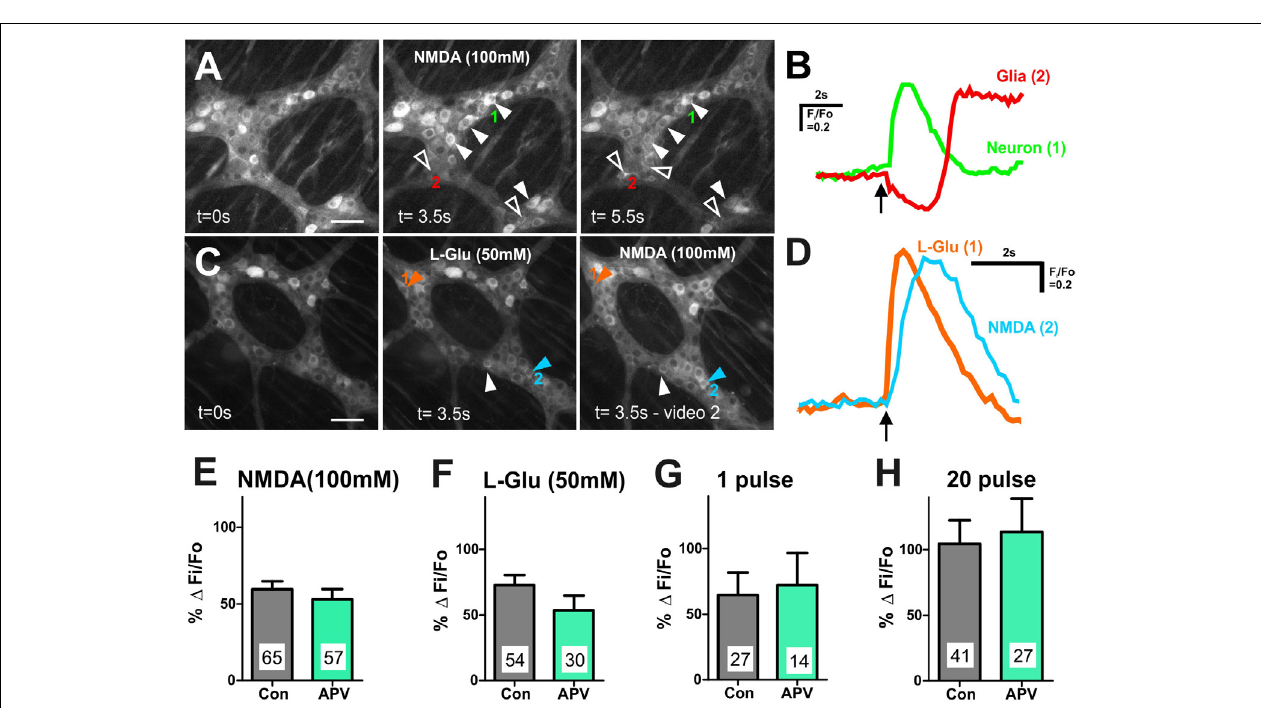
FIGURE 4 | Many myenteric neurons exhibited [Ca 2 + ] i transients in response to L -Glu and NMDA. (A) Representative fluorescence micrographs of NMDA (100 mM) evoked [Ca 2 + ] i transients in myenteric neurons (filled arrowheads) and glia (open arrowheads) [GCaMP3 signal at rest ( t = 0 s) and during NMDA spritz in neurons ( t = 3.5 s) and in glia ( t = 5.5 s)]. (B) Example traces from a neuron (1) and a glial cell (2; marked in A ) that responded to L -Glu. Glial cell shows delayed response to NMDA compared to the GCaMP3+ neuron. Arrow indicates NMDA application. (C) Representative fluorescence micrographs of L -Glu (50 mM) and NMDA (100 mM) evoked [Ca 2 + ] i transients in myenteric neurons [GCaMP3 signal at rest ( t = 0 s) and during L -Glu stimulation and NMDA stimulation, respectively]. Most L -Glu responding neurons also respond to NMDA (filled arrowhead). Some neurons either respond to L -Glu (orange arrowhead) or NMDA (blue arrowhead). (D) [Ca 2 + ] i transient traces obtained from neuron 1 and neuron 2 (marked in C ). Arrow indicates drug application. Histograms showing pooled [Ca 2 + ] i transient amplitudes from all neurons stimulated with NMDA (E) and L -Glu (F) , and from L -Glu responding neurons stimulated with 1 pulse (G) and 20 pulse (H) in time control (con) and in the presence of APV. Changes in amplitude after application APV are presented as a percentage of the first response in control saline (% (cid:49) F i / F 0 ). APV did not alter the amplitude of agonist or electrically evoked [Ca 2 + ] i transients in myenteric neurons. All scale bars 50 µ m. Number of neurons examined are indicated on the bar